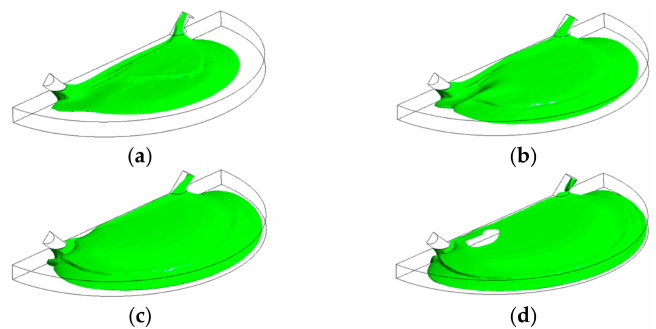
Figure 8. Free-surface during chamber flooding at the following times: ( a ) 0.1 s < τ c ; ( b ) 0.15 s < τ c ; ( c ) 0.2 s ≈ τ c ; ( d ) 0.25 s < τ c, at an inlet liquid flow rate of 1000 µ L/min ( τ c = 0.193 s).